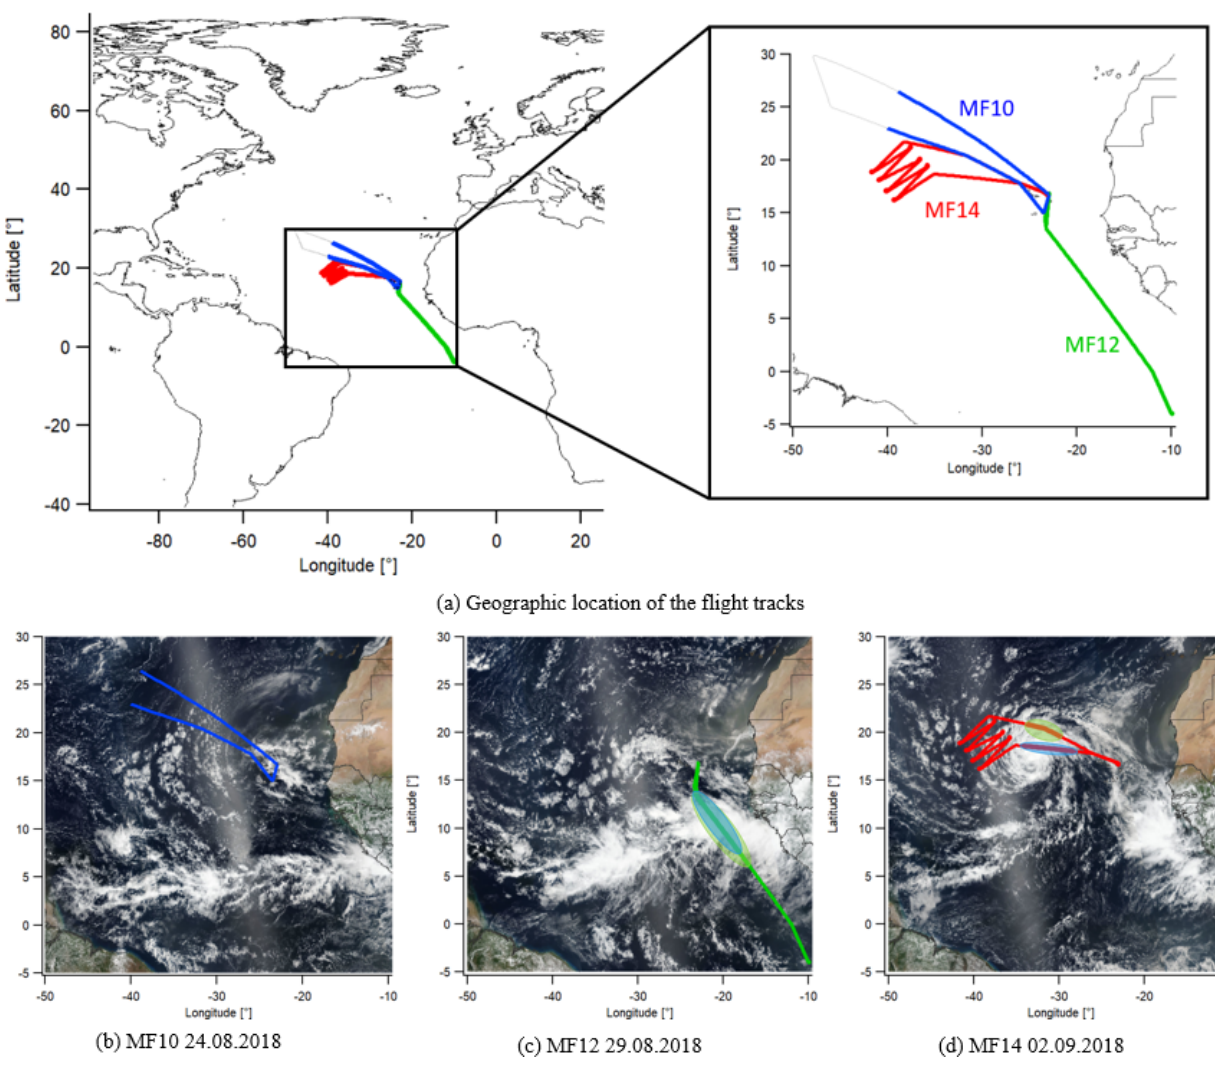
Figure 1. Overview of the flight tracks including satellite images obtained on the day of observation from the NASA Worldview application (NASA Worldview, 2020). Blue: MF10 on 24 August as comparison flight. Green: MF12 on 29 August over the tropical wave. Red: MF14 on 2 September over tropical storm Florence. Marked areas indicate